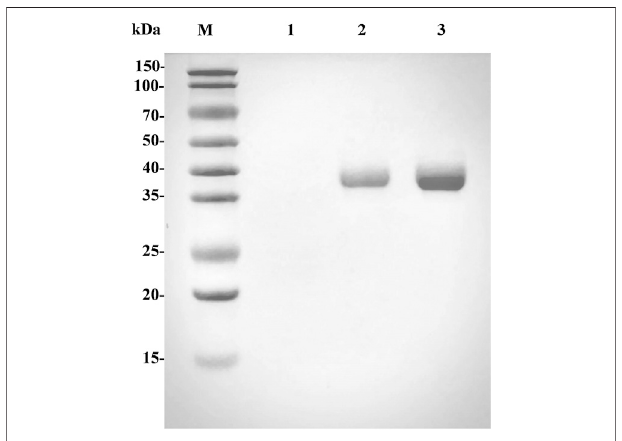
FIGURE. 2 | SDS-PAGE analysis of the expressed and puri fi ed L- Lc LDH1 Q88A/I229A (Pp). Lane M, standard protein molecular mass markers; lane 1, the cultured supernatant of GS115/pPIC9K; lane 2, the cultured supernatant of GS115/L- lcldh1 Q88A/I229A ; lane 3, the puri fi ed L- Lc LDH1 Q88A/I229A (Pp).